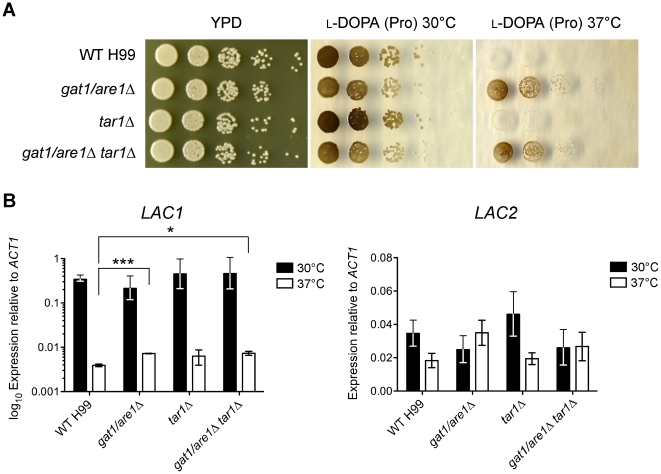
Gat1/Are1 negatively regulates melanin production and LAC1 expression at 37°C.(A) Tenfold spot dilution assays for melanization showed that the gat1/are1Δ and double gat1/are1Δ tar1Δ mutants produce more melanin than the wild-type and tar1Δ mutant strains on l-DOPA medium supplemented with 10 mM proline at 37°C. (B) cDNA from wild-type H99 and the mutant strains grown in l-DOPA (10 mM proline) at 30 and 37°C were amplified via qRT-PCR using primers against the laccase-encoding genes LAC1 and LAC2, and the control gene ACT1. LAC1 expression was significantly higher in the gat1/are1Δ and double gat1/are1Δ tar1Δ mutants compared to wild-type or the tar1Δ mutant when strains were grown at 37°C (* denotes P<0.05, *** denotes P<0.001). Error bars represent standard errors across three biological replicates.